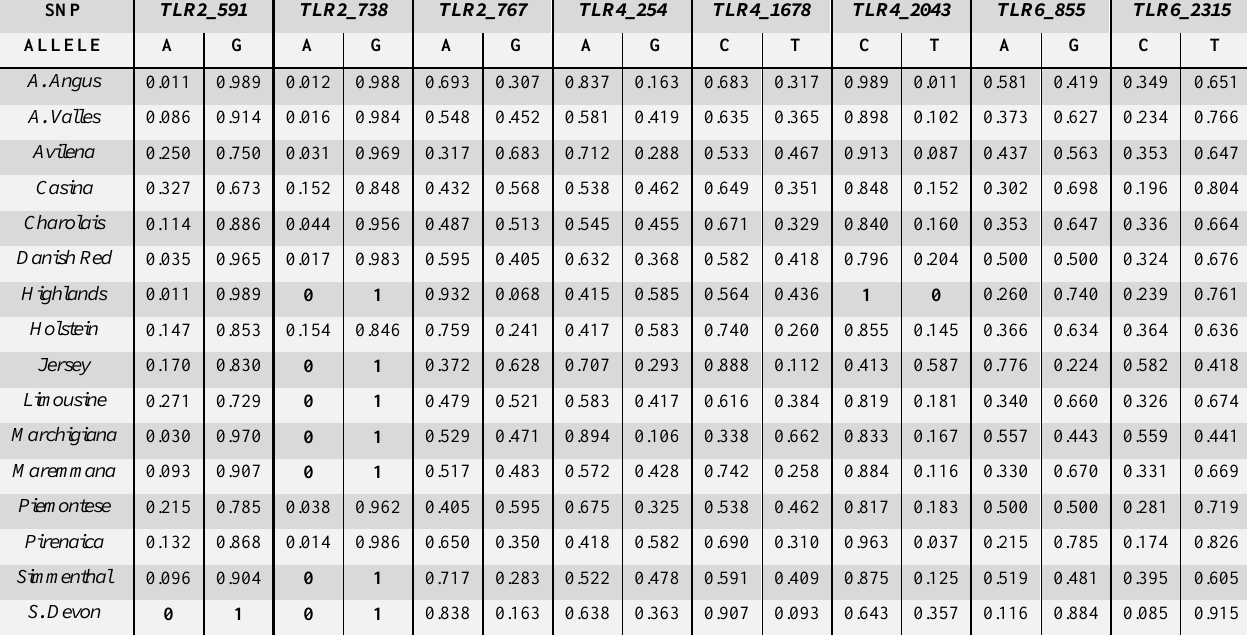
Table 4. Allelic frequencies in the 16 European cattle